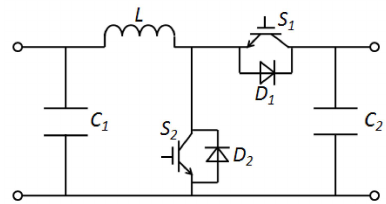
Figure 5. The half-bridge structure of the bi-directional dc/dc